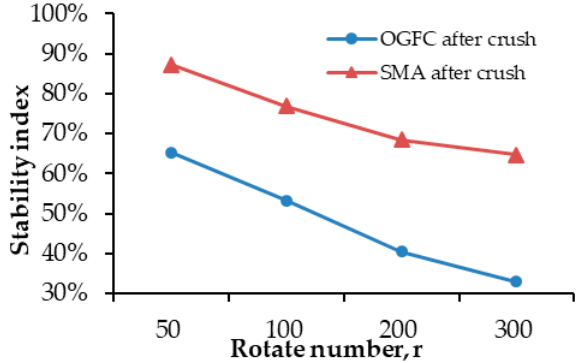
Figure 13. Stability Index of old OGFC and SMA materials.